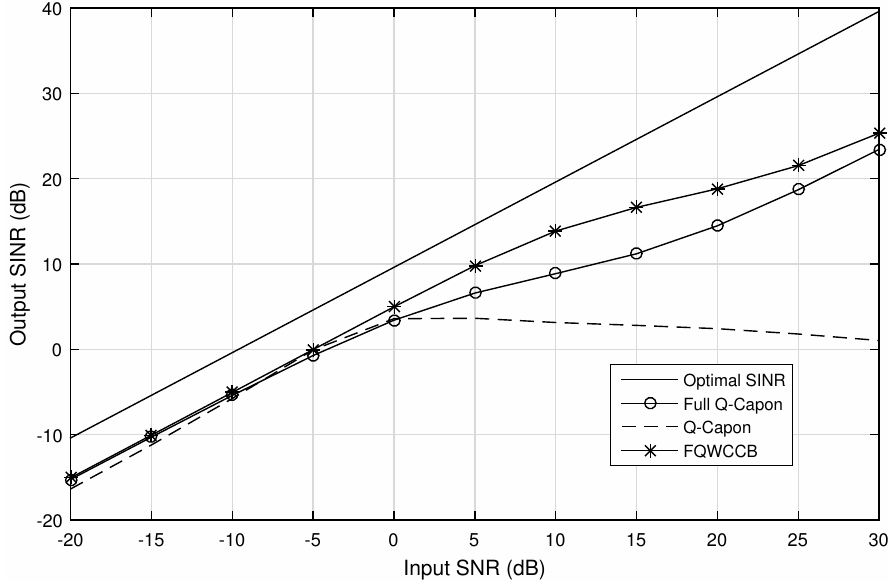
Figure 7. Output SINR versus input SNR for snapshots number 100, with 5 ◦